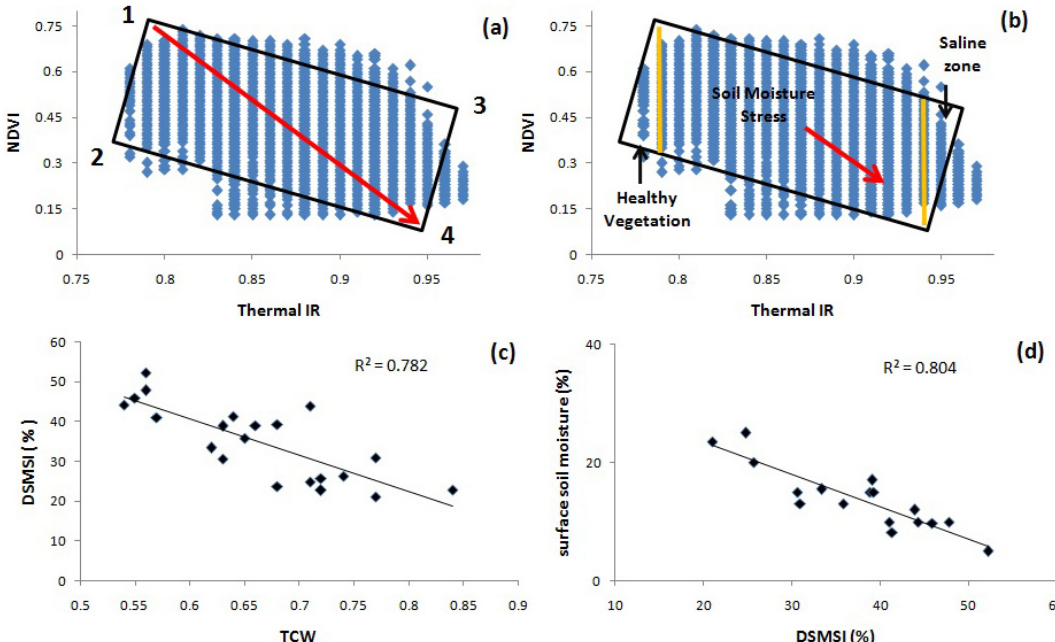
Figure 3. (a) Scatter plot – Thermal IR Vs NDVI – Diagrammatic approximation of the distribution – Diagonal from extreme wet edge 1 to extreme dry edge 4. (b) Three zones of scatter plot such as healthy zone with maximum NDVI and low temperature, soil moisture stress zone which keeps on increasing with increasing diagonal distance from wet edge and saline zone at the extreme portion of the rectangle where the temperature is high and NDVI is almost zero. (c) Linear regression between Diagonal Soil Moisture Stress Index (DSMSI) and Tasseled Cap wetness index (TCW) ( R 2 = 0 . 782) to ensure the theoretical reliability of the result. (d) Linear regression between DSMSI and in situ observations agrees with good accuracy ( R 2 = 0 . 804) of the